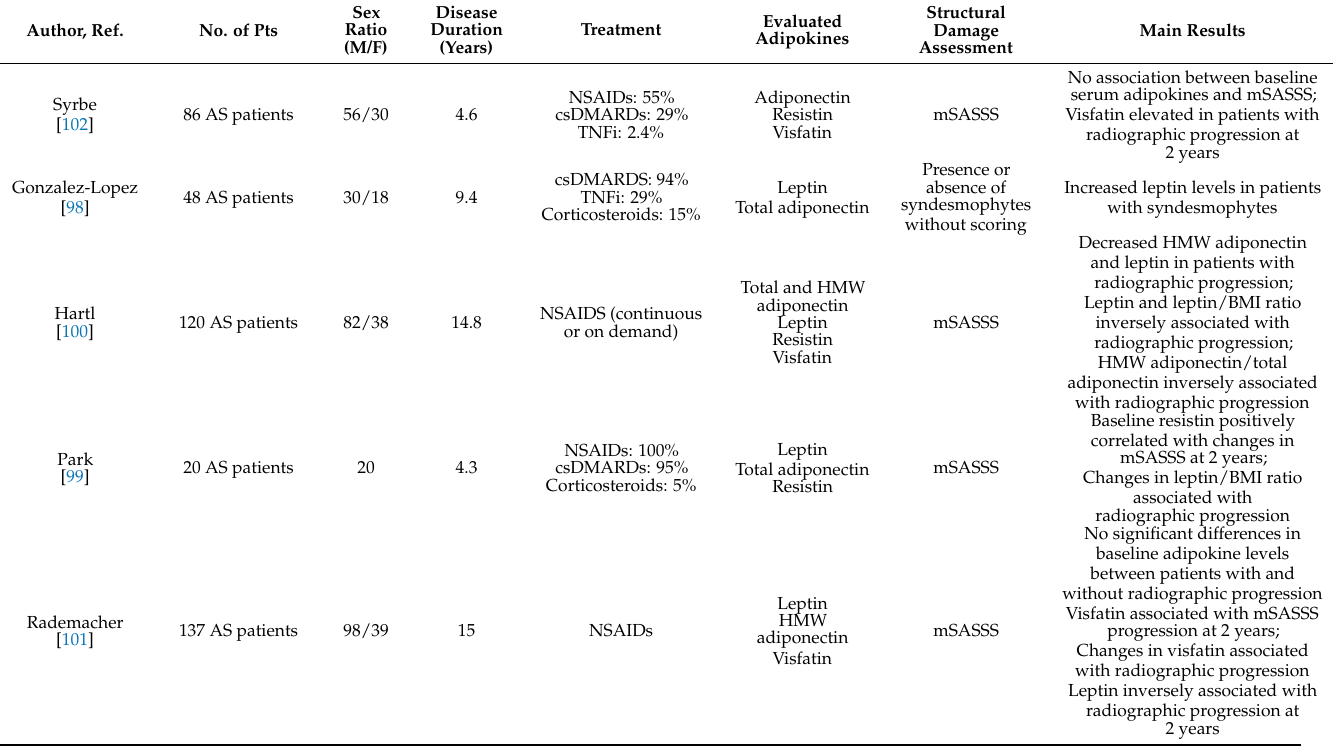
Table 2. Relationships between adipokines and radiographic progression in axial spondyloarthritis.